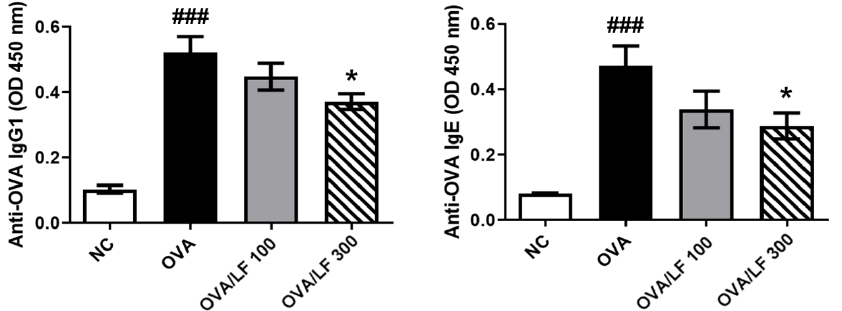
Figure 3. Effects of lactoferrin on OVA-specific IgG1 and IgE production in serum. The levels of OVA-specific IgG1 and IgE were detected by ELISAs. The data are expressed as the mean ± S.E.M. values ( n = 5). ### p < 0.001 vs. the NC group; * p < 0.05 vs. the OVA group. NC: Normal control; OVA: ovalbumin; OVA/LF 100: OVA + lactoferrin 100 mg/kg; OVA/LF 300: OVA + lactoferrin 300 mg/kg.